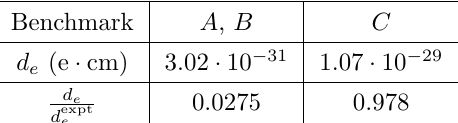
Table 5. Numerical electron EDM results for benchmark points, including the ratio with respect to the current experimental bound given in eq. (3.2). The results of benchmark points A and B are approximately equal as they only di(cid:11)er in the (cid:21) 1 L Yukawa coupling which plays a subdominant role